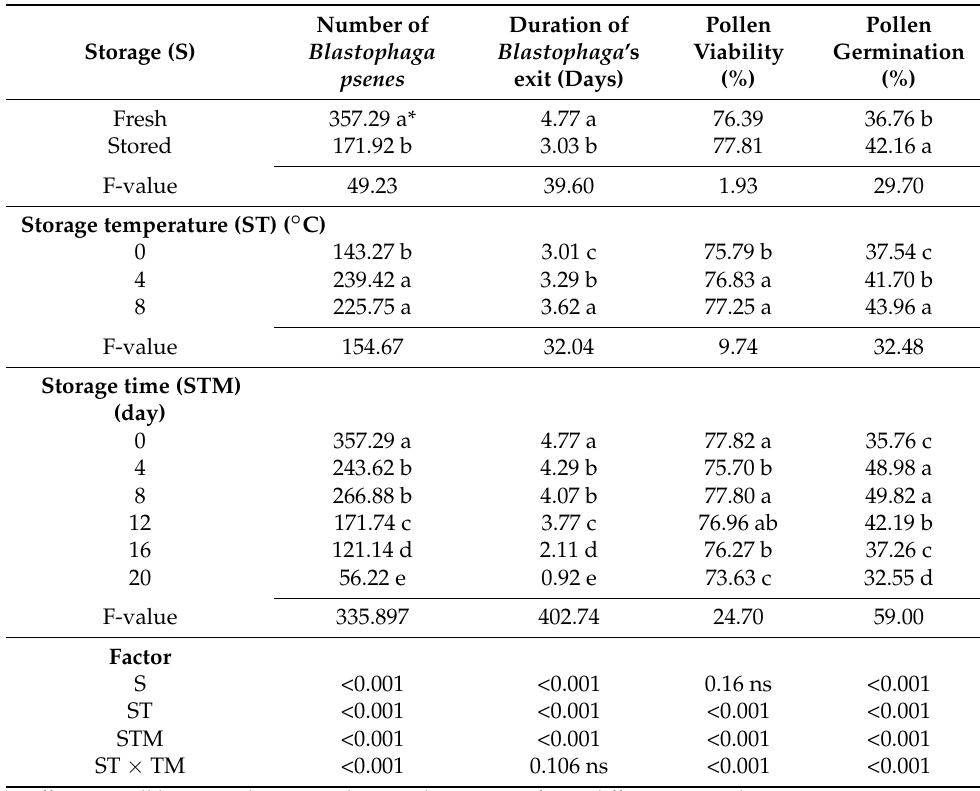
Pollen Pollen Duration of Number of Blastophaga ’s Blastophaga Germination Viability psenes (%) (%) exit (Days)